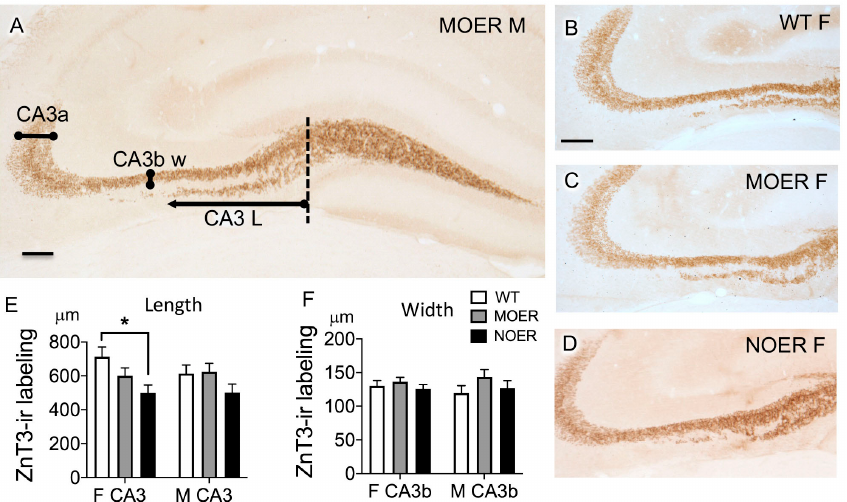
Figure 8. Light microscopic localization of ZnT3 labeling in the mossy fiber pathway from WT, MOER, and NOER mice. ( A ) Representative section of the dorsal hippocampus showing region of CA3 labeled for ZnT3 measured for width (CA3a and CA3b SLu) and length (region of CA3 SO contiguous with the hilus). For consistency, the notch where SO meets the molecular layer of the DG was used as the starting point of the length measure (vertical dashed line). ( B – D ) Examples show differences in the length of ZnT3 labeling in CA3 SO from WT ( B ), MOER ( C ), and NOER ( D ) female mice. ( E ) . The length of ZnT3 labeling in CA3 SO was significantly shorter in the NOER compared to the WT female mice. ( F ). No significant differences were seen in the width of CA3b SLu from any of the mice from either sex ( n = 4 WT, 6 MOER, and 6 NOER females; n = 4 each for WT, MOER, and NOER males); * p < 0.05; scale bar ( A – D ) = 100 microns. 4. Discussion This study builds on our previous work to further elucidate the effects of selective expression of nuclear or membrane estrogen receptors on estrogen-mediated plasticity and signaling in the PVN and hippocampus. Importantly, the absence of nuclear and membrane ER α expression appeared to only impact the females in these brain areas. In the PVN, the absence of nuclear ER α increased nuclear ER β . Moreover, in the hippocampus CA1, the absence of either nuclear or membrane ER α decreased extranuclear ER α and pTrkB in synapses. In contrast, in the DG, the absence of nuclear ER α increased pTrkB in synapses, whereas the absence of membrane ER α decreased pTrkB in axons only. However, the absence of membrane only ER α decreased the sprouting in mossy fibers in CA3. Prior studies in PVN analyzing the distributions of nuclear ER α and ER β in male and female mice revealed sex differences in their topographic distributions [8]. In particular, males have more ER α nuclei in the rostral neuroendocrine regions, whereas females have more ER β -containing neurons in the caudal autonomic regions [8]. Previous studies showed that the loss of ER α in the PVN had no effect on blood pressure, whereas the loss of ER β increased blood pressure [12,42]. Moreover, our recent research in a perimenopausal mouse model suggested that ER β is necessary for the neuroprotective effects on hypertension in the PVN [12]. Thus, the increased expression of ER β in the MOER females suggests that the loss of nuclear ER α expression may offer further protection in female mice to hypertension susceptibility. In the CA1 region of the hippocampus, estrogens modulate numerous synaptic plasticity processes [7,11]. Within the CA1, in vitro and in vivo estrogens increase dendritic spine density and synaptic proteins [11,13]. These estrogen actions are modulated largely by membrane ER α as few nuclear ER α are detected in CA1 [9,43]. This study found that, when either membrane or nuclear estrogen receptors were introduced, extranuclear ER α labeling was significantly reduced in CA1. Concomitant with these